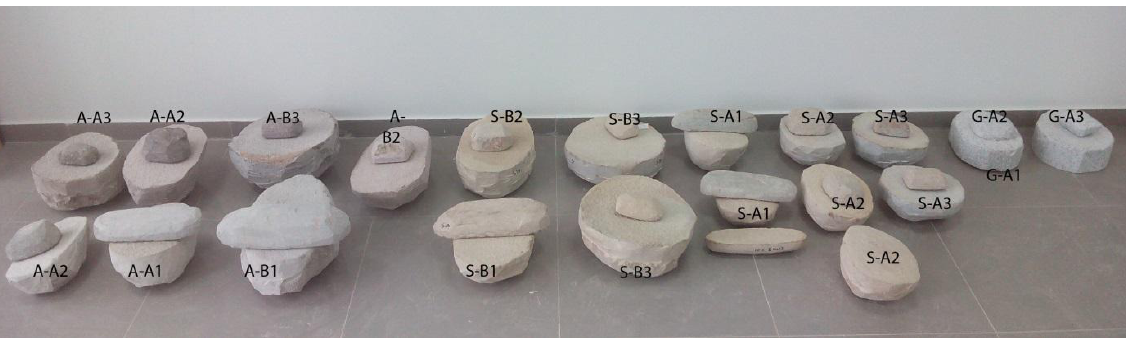
Figure 1. Experimental toolkits of different raw materials, sizes and